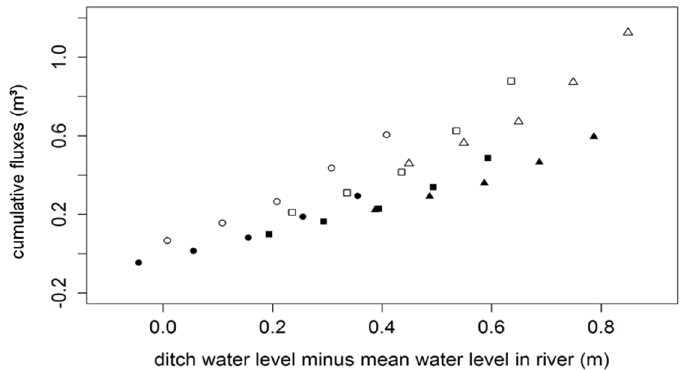
Figure 8. Mean ground water fluxes to the stream depending on the height difference of constant